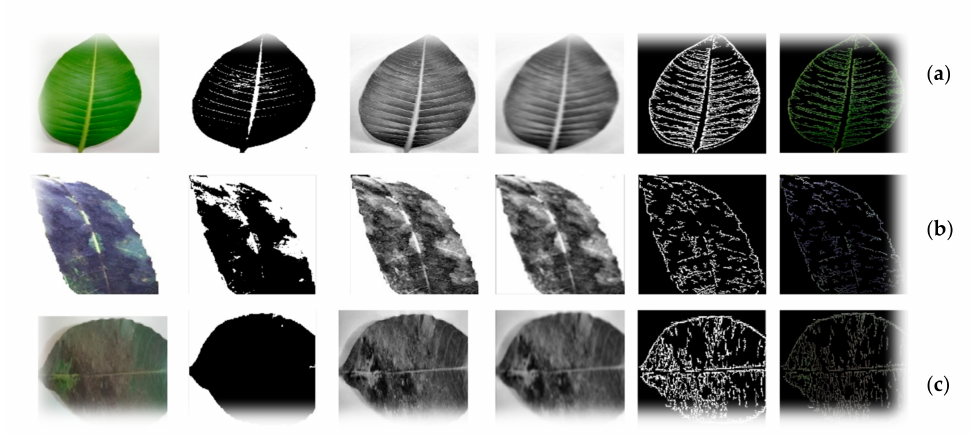
Figure 3. Stepwise output of leaves: ( a ) healthy, ( b ) powdery mildew, and ( c ) sooty mold.